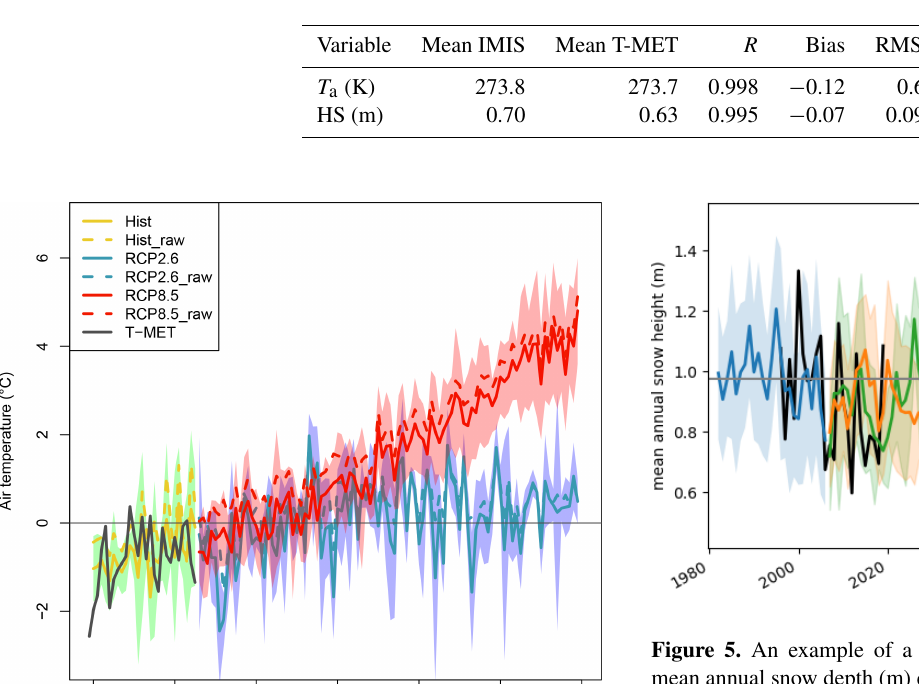
Table 5. Statistics from the evaluation comparing T-MET results with IMIS station data for the historical period, as shown in Fig. 6.